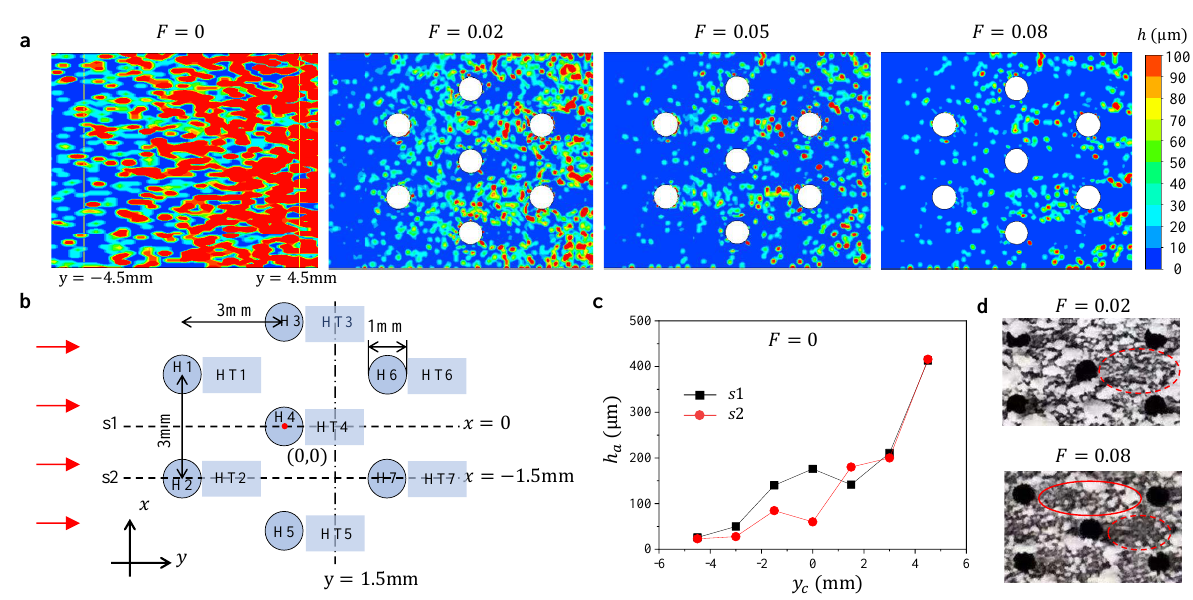
Figure 6. ( a ) Contours of particle deposition thickness h with different blowing ratio F . ( b ) Schematic of the film cooling holes arrangement and the labeled areas. ( c ) The variation of averaged deposition thickness h a with the y coordinate y c of the center point of the chosen areas along s1 and s2. ( d ) Exper- iment snapshots of the particle deposition in the middle of the flat surface at F = 0.02 and F = 0.08. To obtain a quantitative result of the particle deposition on the surface when F > 0, we measure the h a in several 1 mm × 1 mm areas along s1 and s2, avoiding the film cooling holes, and normalize h a using h 0 (Figure 7). The variation of h a / h 0 with y c on s1 and s2 are generally different. For h a / h 0 on s1 (Figure 7a), we observe the increase of h a / h 0 with y c before the film cooling hole H4 (where y c = 0), followed by the drop of h a / h 0 around H4 and then the increase of h a / h 0 with y c . The drop of h a / h 0 is attributed to the cooling flow from H4, which reduces the particle deposition, while the increase of h a / h 0 after H4 may be induced by the reduced effect of the film cooling resulting from the detachment of cooling air from the surface. For h a / h 0 on s2 (Figure 7b), the variation of h a / h 0 with y c over two cooling holes, H2 and H7, are significantly different. The dimensionless thickness h a / h 0 is only observed after the second hole H7 (where y c = 3 mm). The difference in the